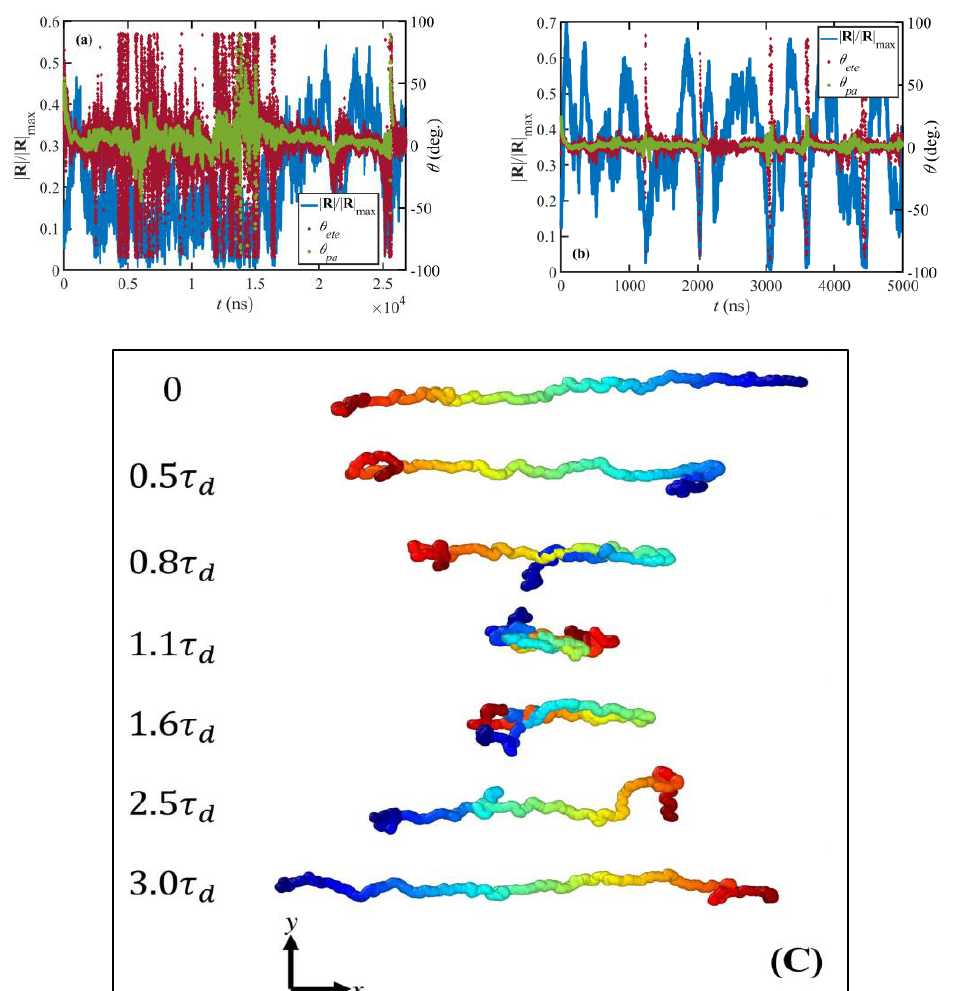
Figure 4. Normalized end-to-end vector and orientation angle vs. time for a random chain at 𝑊𝑖 = 58 ( a ) and 𝑊𝑖 = 1,170 ( b ). A time progression of configurations of a random chain at 𝑊𝑖 = 117 is depicted in panel ( c ). 𝜃 𝑒𝑡𝑒 is the angle between the chain end-to-end vector and the flow direction ( 𝑥 ) and 𝜃 𝑝𝑎 is the angle between the primary axis of the chain and the flow direction.